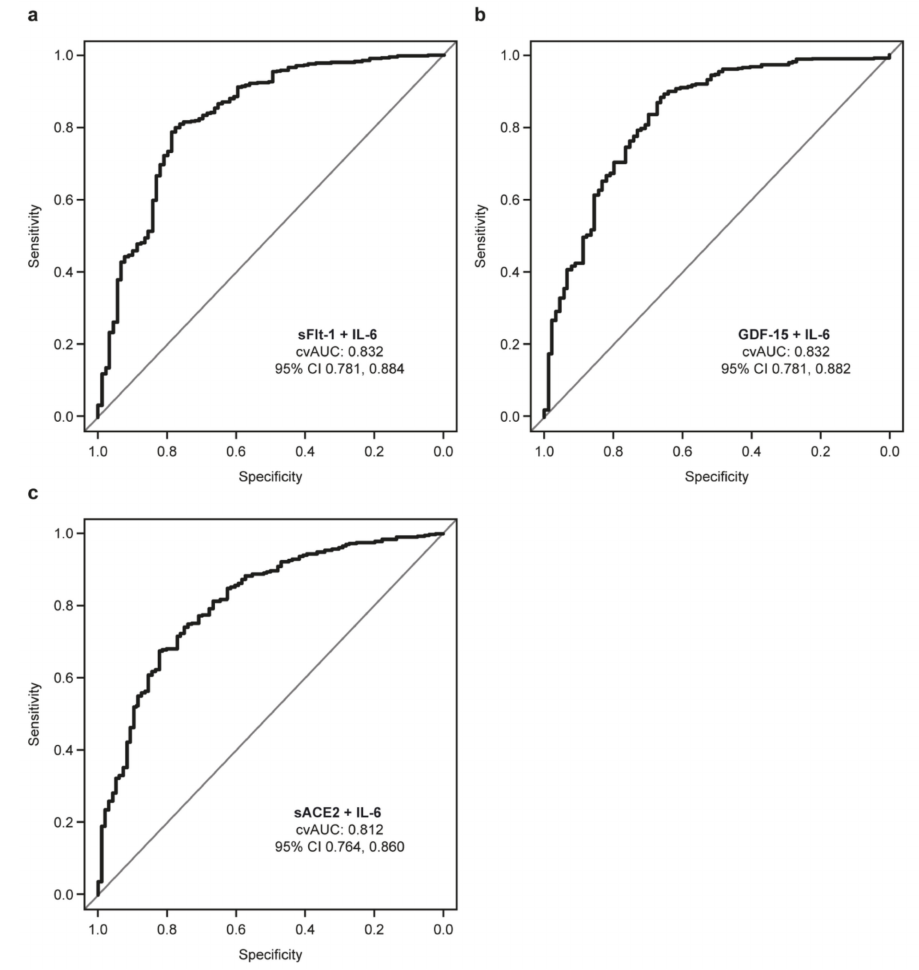
Figure 2. Bivariate analysis performed in patients with SARS-CoV-2 infection who were admitted to hospital (Groups 2–4) versus patients with SARS-CoV-2 infection who were discharged (Group 1). Data are shown as ROC curves for ( a ) sFlt-1 + IL-6, ( b ) GDF-15 + IL-6, and ( c ) sACE2 + IL-6.